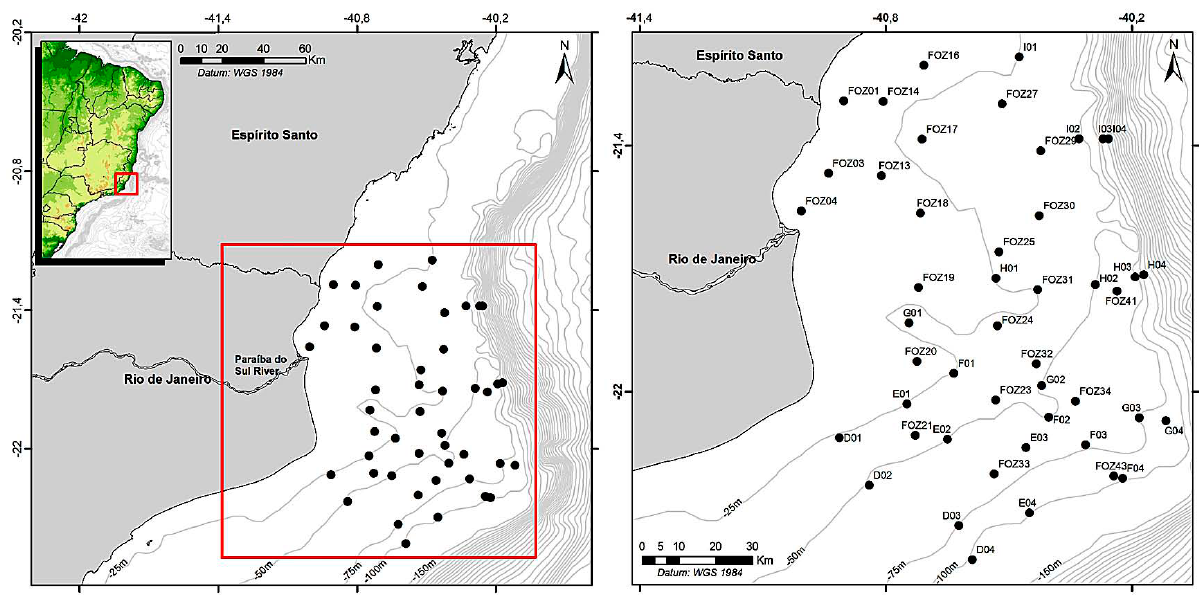
Fig. 1. – A, the study area on the northern coast of the Rio de Janeiro State and southern coast of Espírito Santo State. B, a map showing the locations and depths of the sampling